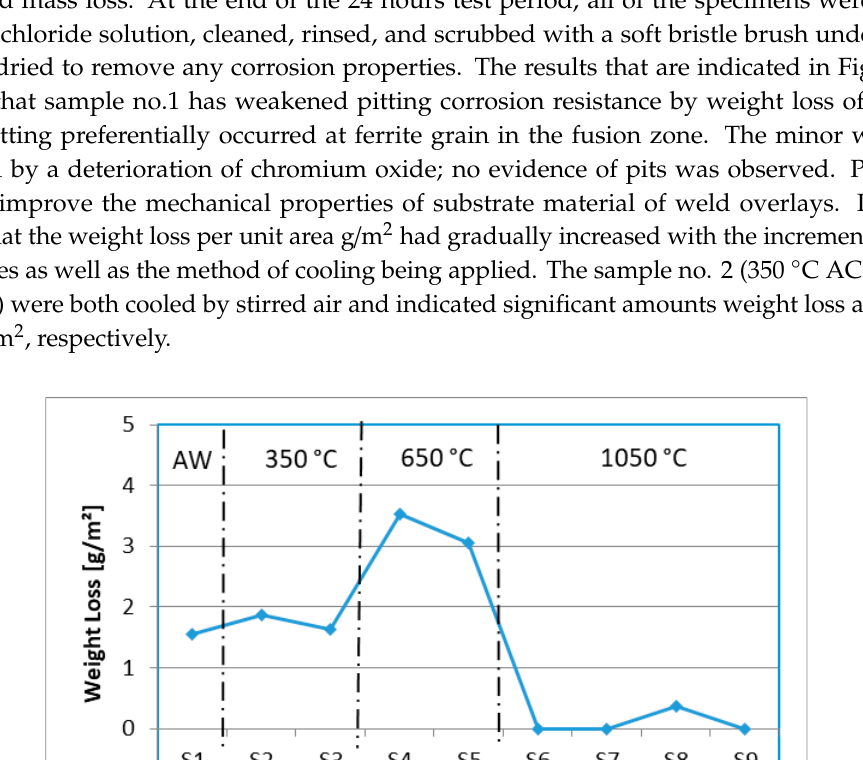
Figure 1. Comparison of weight loss per unit area in different heat treatments.